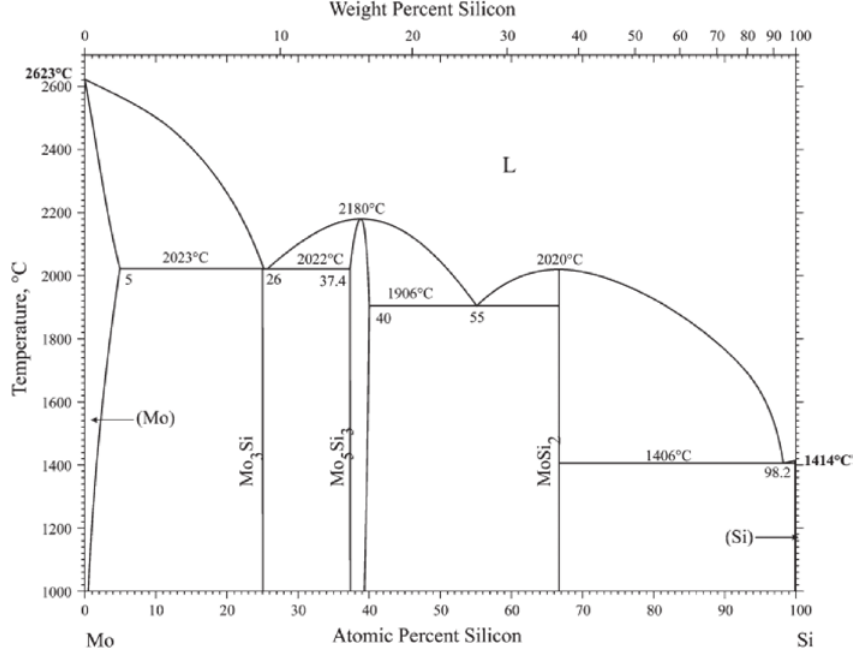
Fig. 6: Si-Mo system phase diagram